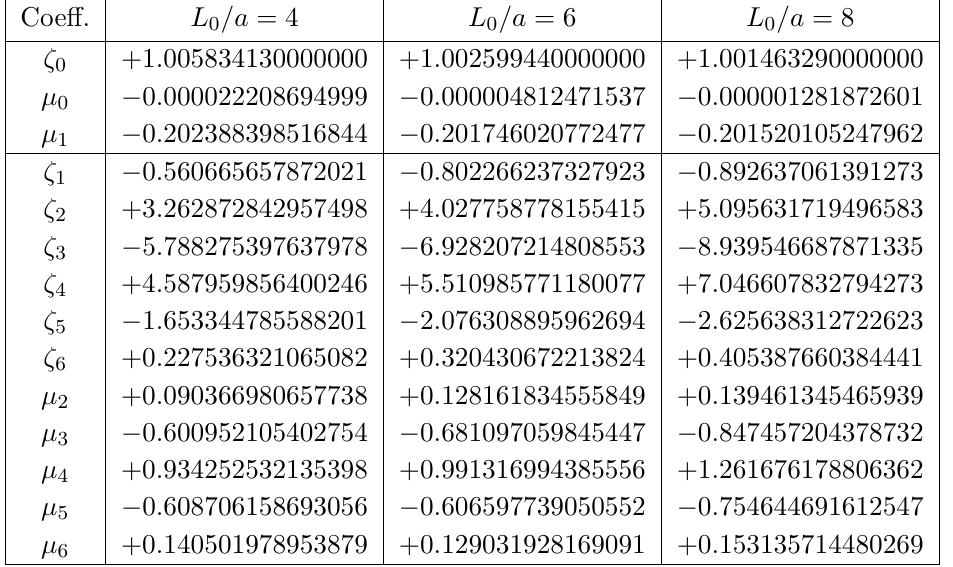
Table 6 . Coefficients for the parameterization eq. (B.16). The three leading coefficients ζ 0 , µ 0 , and µ 1 in the upper part of the table are combinations of known perturbative coefficients while the others were determined by a fit.